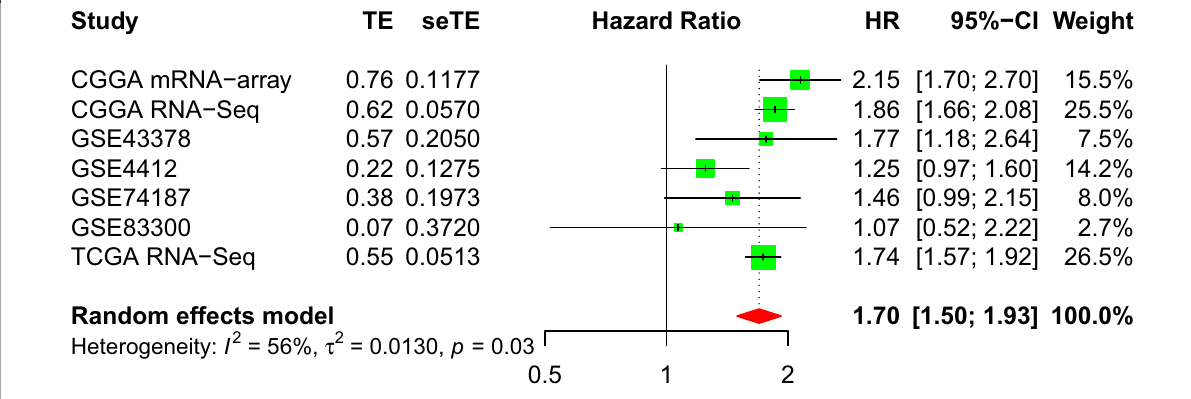
Fig. 6 Forest plot for the relationship between GINS4 expression and OS in glioma patients